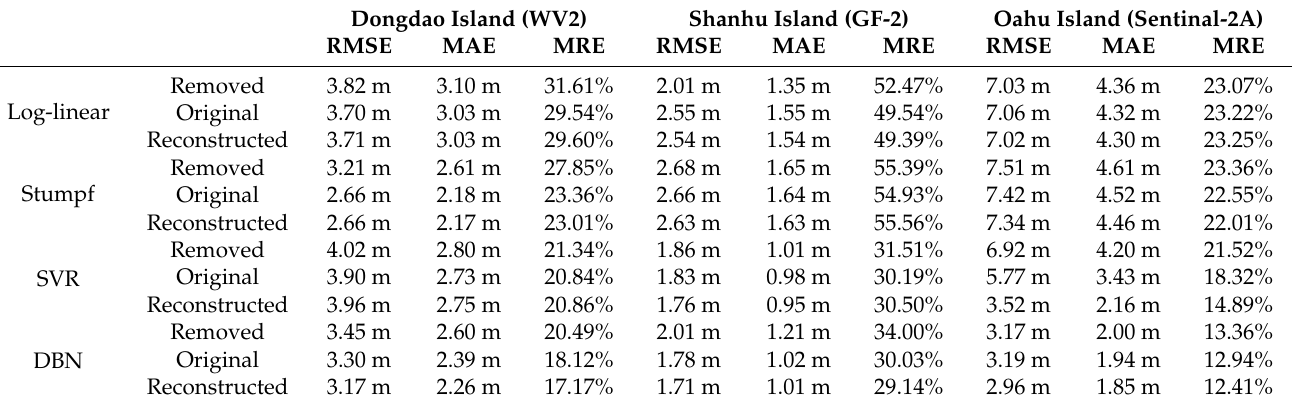
Table 4. Inversion accuracy of the four models with three types of data in three study areas.